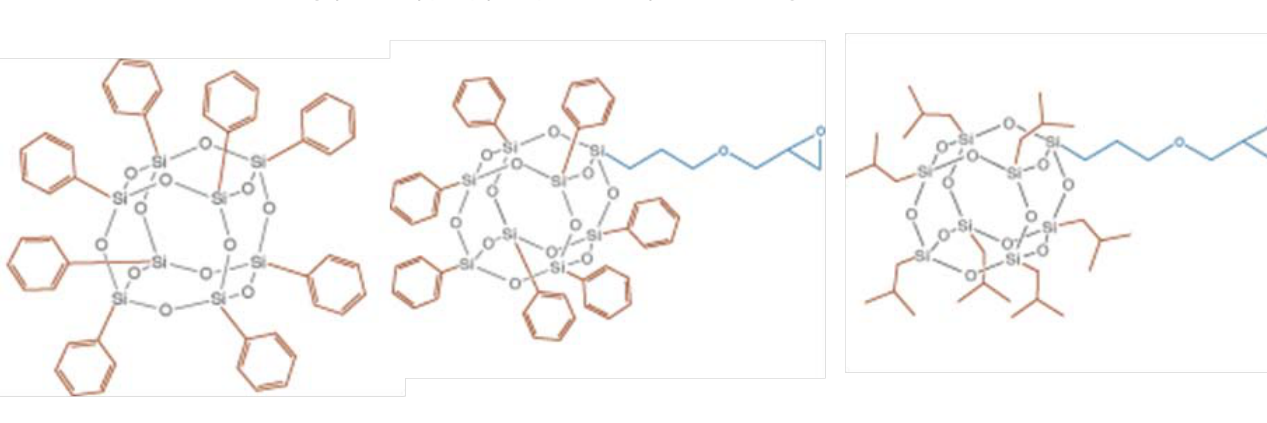
Figure 5. Chemical structures of octaphenyl POSS (left), glycidoxypropyl heptaphenyl POSS (middle) and glycidoxypropylheptaisobutyl POSS (right)